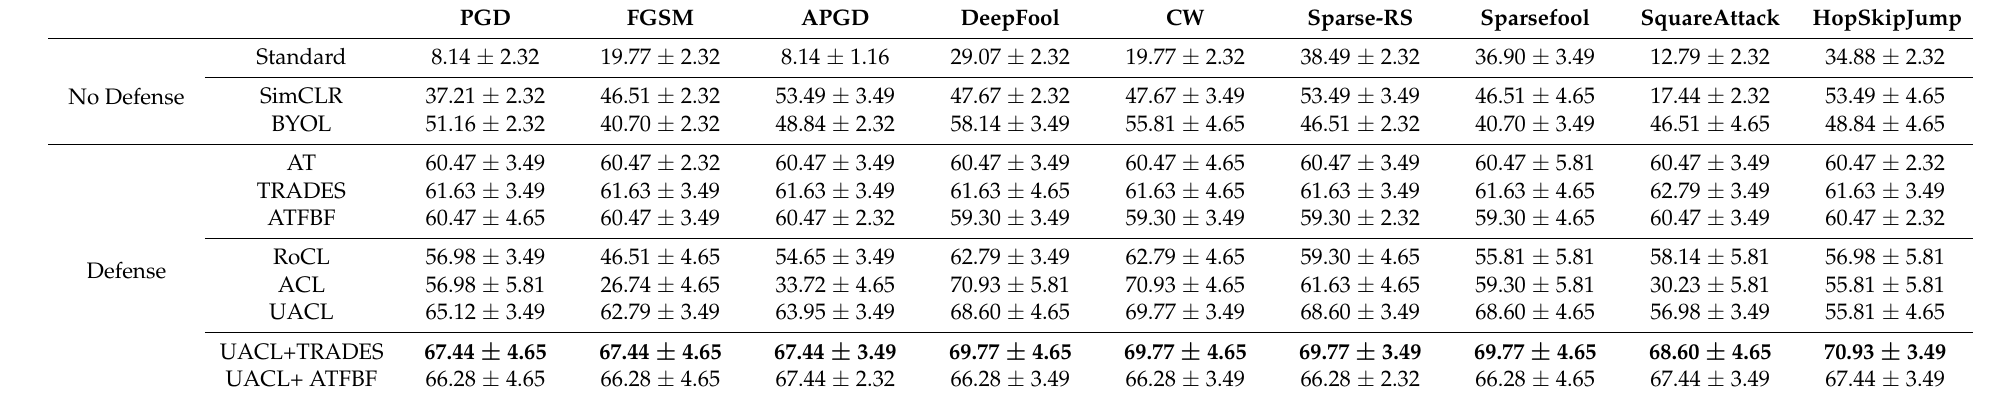
Table 12. Classification accuracy of models (ResNet18) with no-defense or defense methods against different kinds of adversarial attack in FUSAR-Ship dataset. PGD FGSM APGD DeepFool CW Sparse-RS Sparsefool SquareAttack